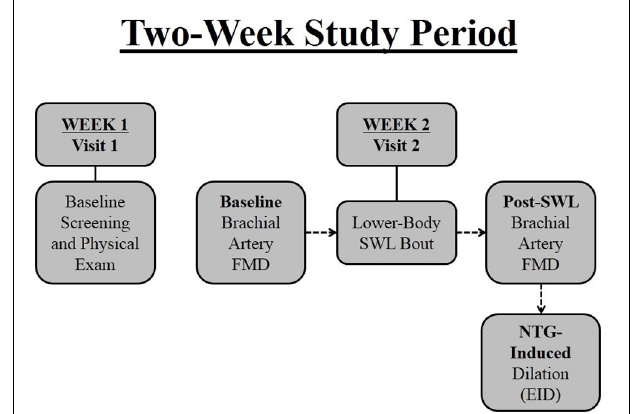
FIGURE 1 | Two-week research study timeline. Subjects were screened at baseline (Visit 1) by way of questionnaires and a physical examination. Approximately 1 week later (Visit 2) brachial artery flow-mediated dilation (FMD) was assessed in all subjects prior to and after performance of a single bout of bilateral lower-body strenuous weight lifting (SWL). Subjects were administered nitroglycerin approximately 10min after FMD for measurement of brachial artery endothelium-independent dilation